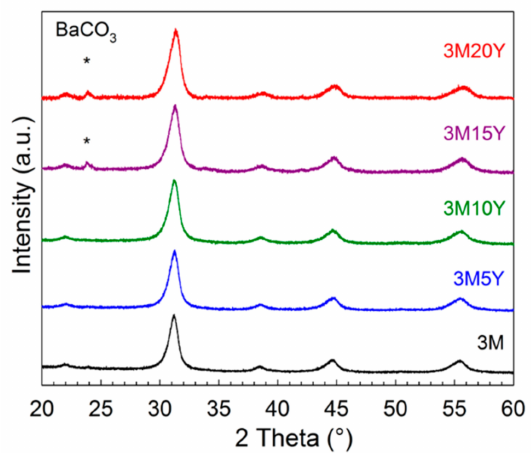
Figure 2. XRD patterns at room temperature of materials with nominal compositions of La 0.3 Ba 0.7 Zr 0.4 − w Y w Co 0.2 Mn 0.2 Fe 0.2 O 3 − δ annealed at 700 ◦ C in N 2 . All compositions form a single phase with a cubic perovskite structure. BaCO 3 (*) was visible for the 3M15Y and 3M20Y